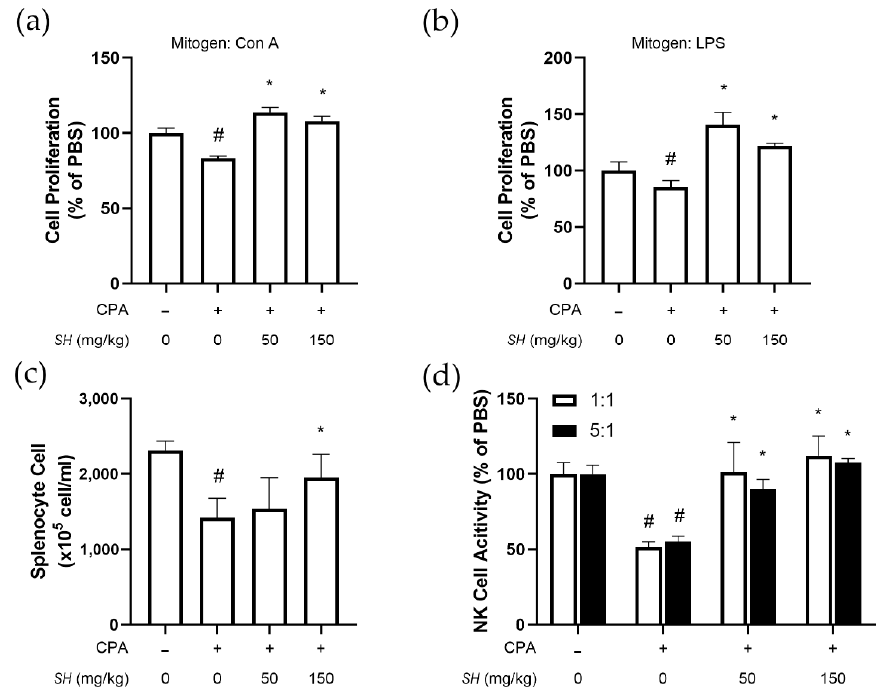
Figure 5. Effects of SH on immune functions of splenocytes isolated from CPA-induced immunosup- pressed mice. SH was orally administrated in BALB/c mice for 14 days. CPA was injected on days 14 and 16 to induce immunosuppression. After sacrifice, splenocytes were isolated, and ( a ) splenocyte numbers and proliferation in response to ( b ) Con A or ( c ) LPS were measured. ( d ) NK cells were purified from splenocytes, and YAC-1-targeting activity was measured. # p < 0.05 vs. splenocytes from naïve mice, * p < 0.05 vs. splenocytes from CPA-injected mice. Results are dis- played as mean ± SD of three or more separate experiments.